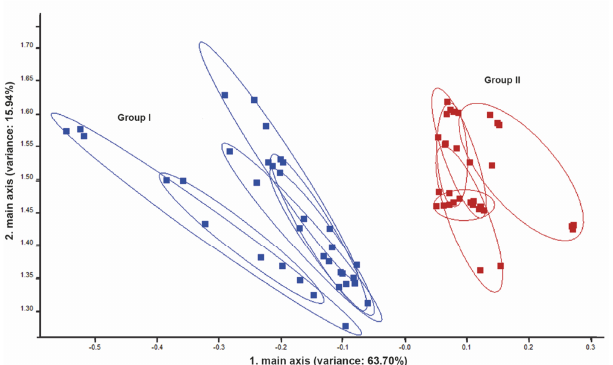
Figure 6. PCA for exhalated breath for cows from groups I and II after 250 g of LD and FD ingestion, respectively. Note the high discrimination between the two groups. The numbers in parentheses indicate the percentages of the data matrix described by the relevant components and functions. Considering only group I, PCA of breath revealed discrimination between exhaled VOCs measured after 250 g of LD and after 250 g of LD and pellet concentrate ingestion (Figure 7a). Furthermore, among group II, similar to group I, PCA of breath revealed dis- crimination between exhaled VOCs measured after 250 g of FD and after 250 g of LD and pellet concentrate ingestion (Figure 7b).